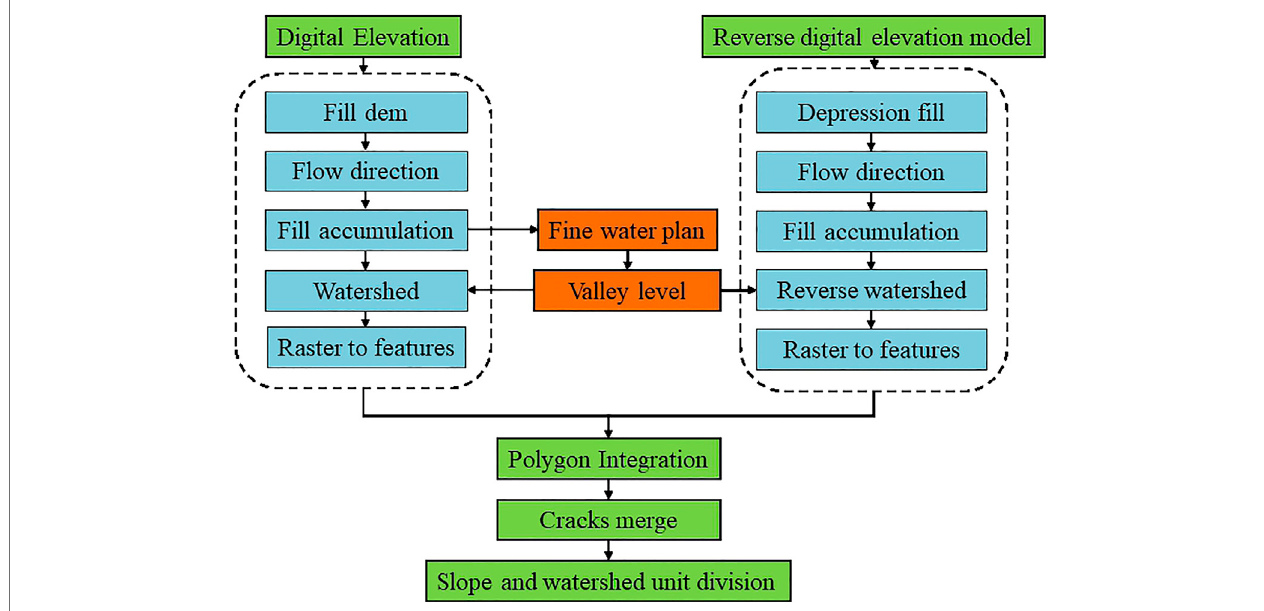
FIGURE 2 | Flow chart of hydrological